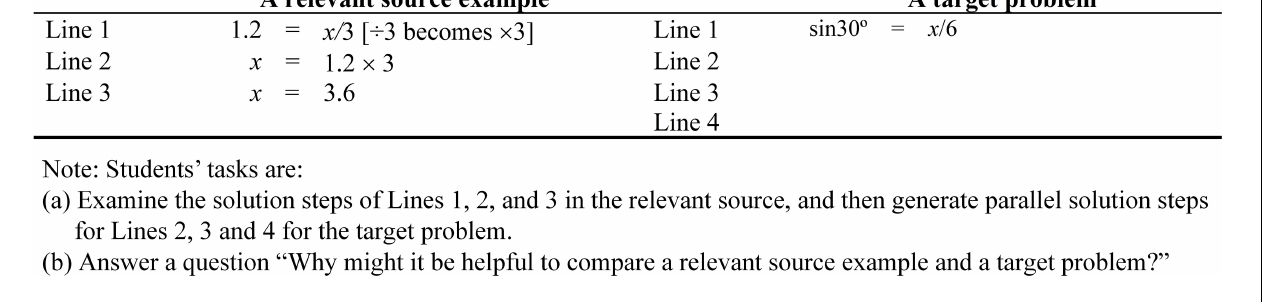
FIGURE 2 | Solution procedure of a relevant source example and a target